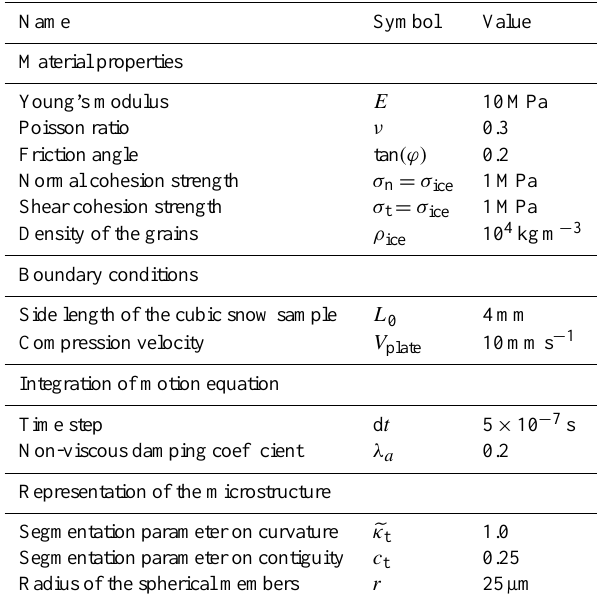
Table 2. Model parameters used for the simulations presented in this